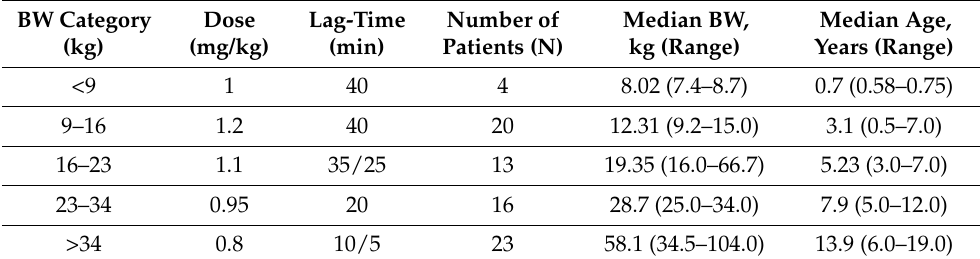
Table 2. Dosing chart including weight and age distribution for each